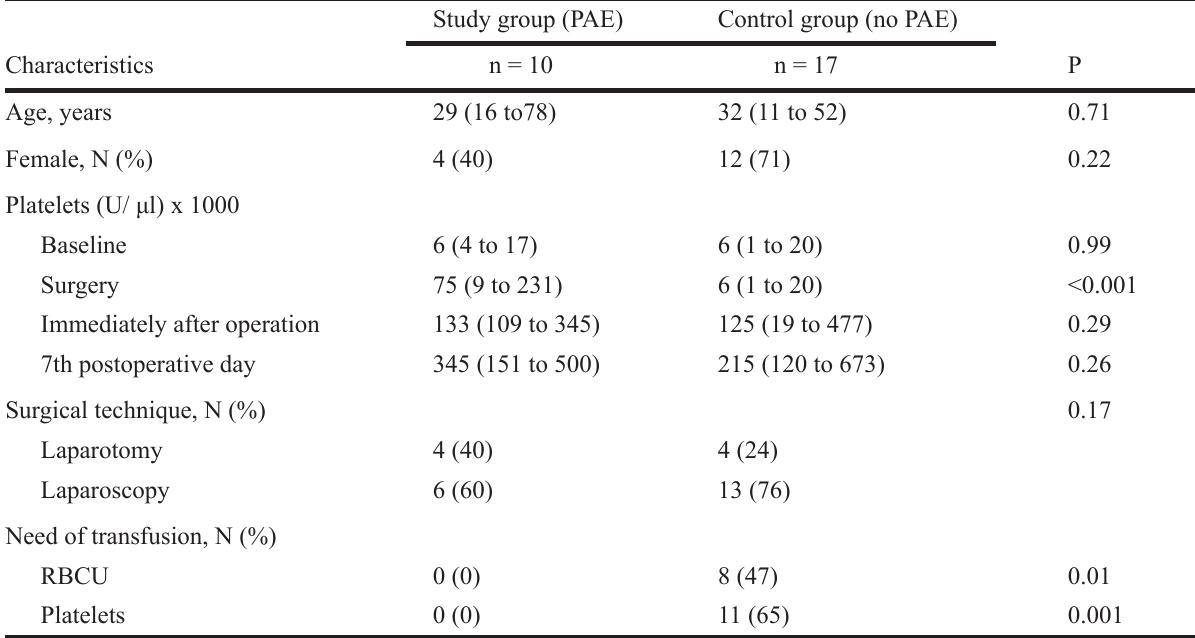
TABLE 1 - Characteristics of patients that underwent splenectomy for immune thrombocytopenic purpura (ITP) with or without preoperative embolization of the splenic artery